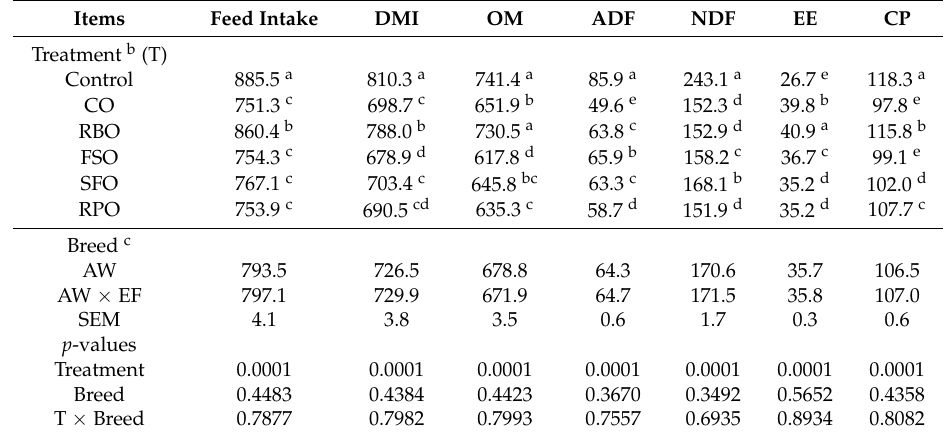
Table 3. Least square means and standard errors (LSM ± SEM) of experimental feed intake a